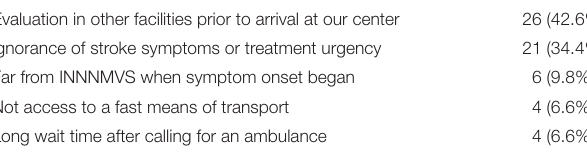
TABLE 3 | Perception of patient/primary caregiver about the reasons for the delay in arriving to the ED at the INNNMVS after the onset of symptoms ( n =